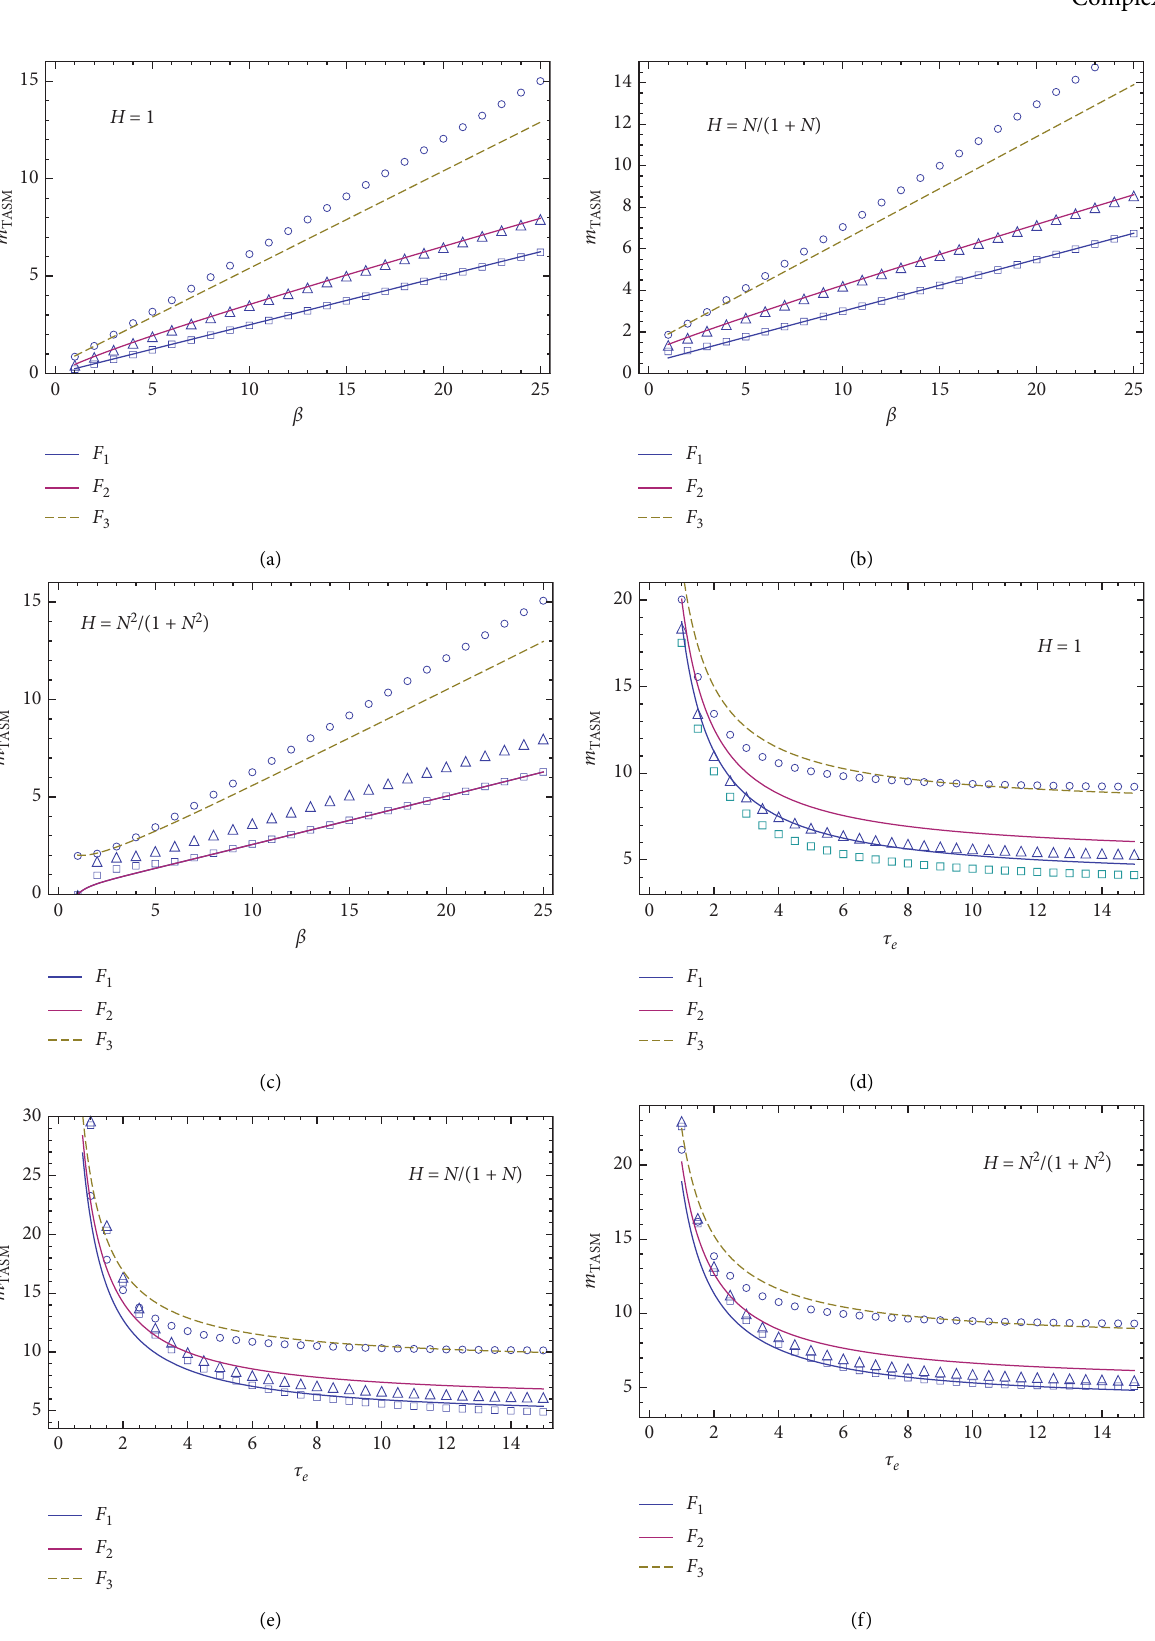
Figure 4: Theoretical and simulated m , in the case of continuous mass release strategy, as a function of β and as a function of τ e . TASM Parameters values are r � 1, δ � 1, τ s � 1, α � 0 . 8, and c � 0 . 5. (a) Parameters values are τ e � 500, (b) parameters values are τ e � 500, (c) parameters values are τ e � 100, (d) parameters values are β � 15 (e) parameters values are β � 15, and (f) parameters values are β �